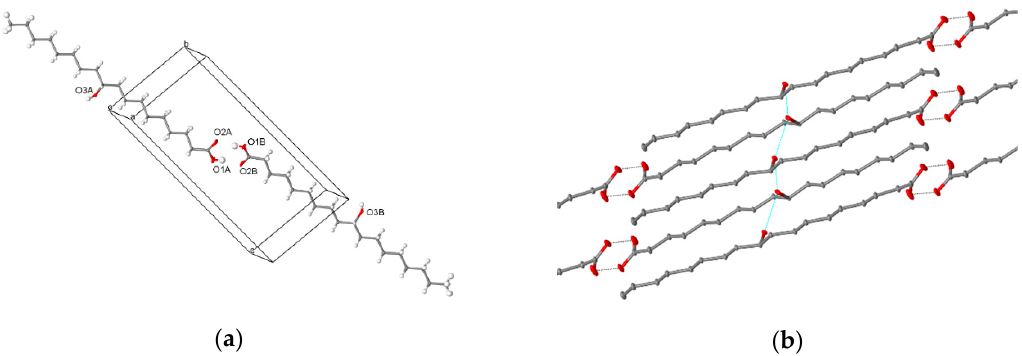
Figure 7. Crystal structure of ( R )-10-HSA crystallized from a mixture of petroleum ether and ethyl acetate: ( a ) crystallographically independent unit, forming a dimer through hydrogen bonding interactions of the carboxylic moieties and ( b ) hydrogen-bonding interactions involving the hydroxyl group at position 10 of the alkyl chain leading to head-to-tail packing of molecules in the crystal.